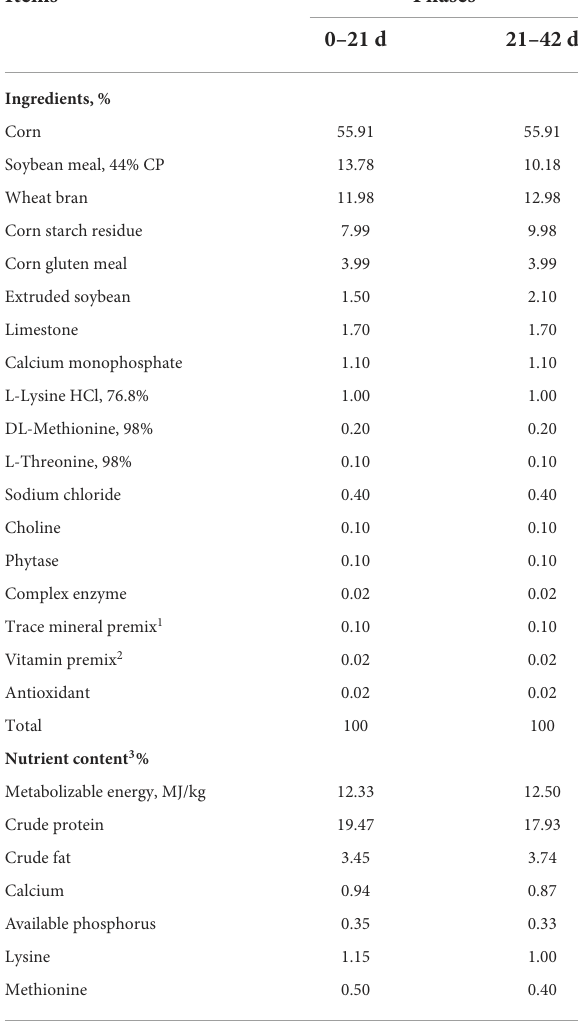
TABLE 1 Ingredients composition and nutrient levels of basal diets (as-fed